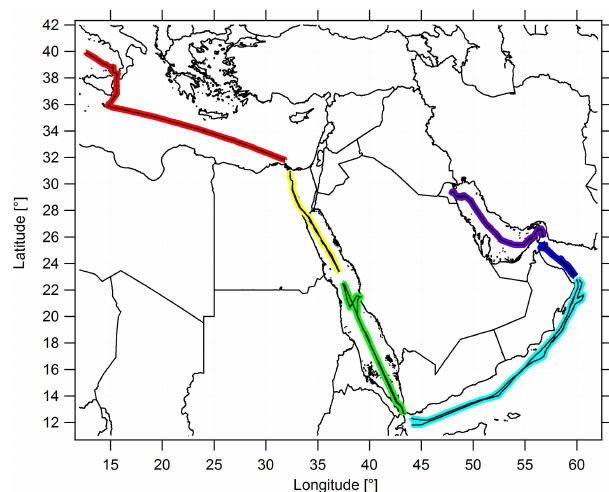
Figure 1. The ship cruise during both legs, and the color-coded sub- division of the ship’s route into six different regimes. The following abbreviations are used throughout the paper to refer to the subdi- visions: AG for the Arabian Gulf (purple), OG for the Oman Gulf (dark blue), AS for the Arabian Sea (blue), SRS for the southern Red Sea (green), NRS for the northern Red Sea (yellow) and M for the Mediterranean